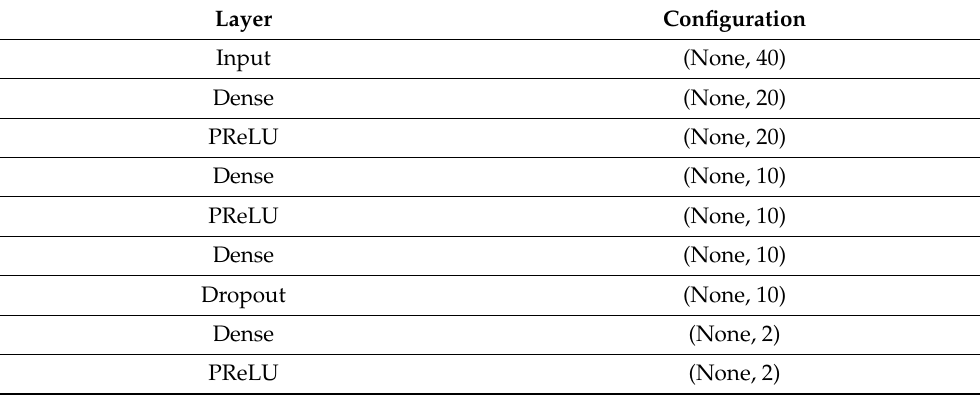
Table 2. Configuration of D A and D B of SDGAN.